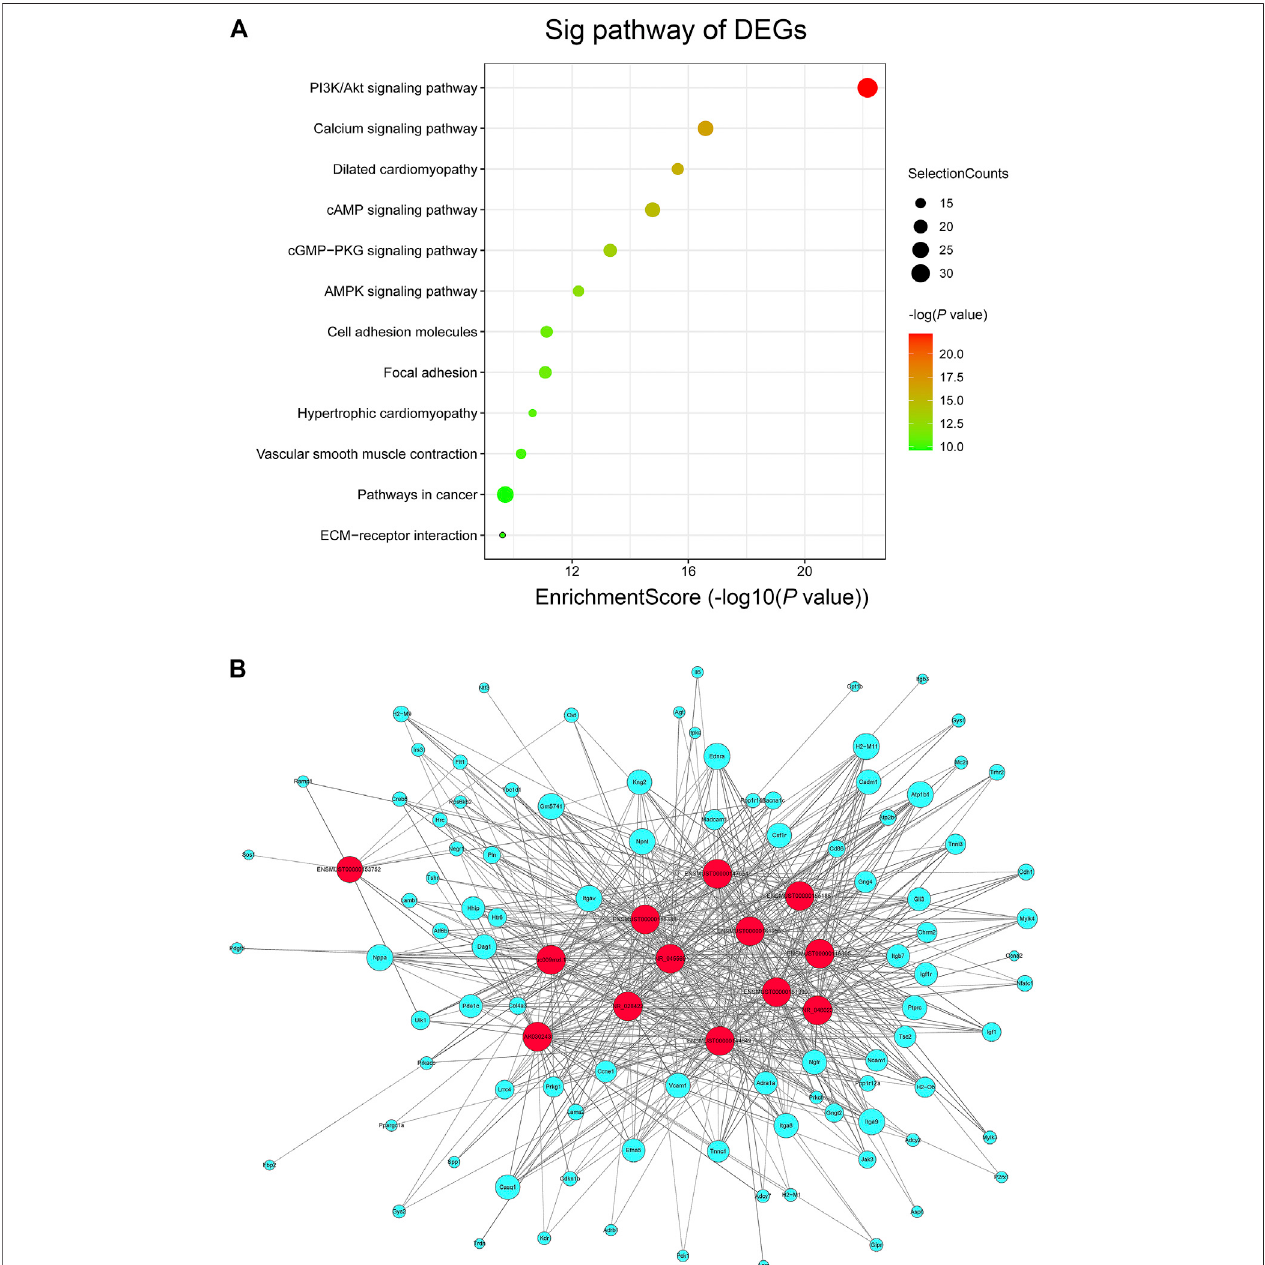
FIGURE 4 | LncRNA-mRNA co-expression network. (A) KEGG pathway enrichment analysis of differentially expressed genes (DEGs) involved in the vascular regulation. (B) lncRNA-mRNA network to investigate the bene fi cial effects of MK-626 on hypertension-induced endothelial function. The red and lake blue nodes correspond to lncRNAs and coding genes respectively. The solid lines represent positive correlation and dotted lines represent negative correlation.